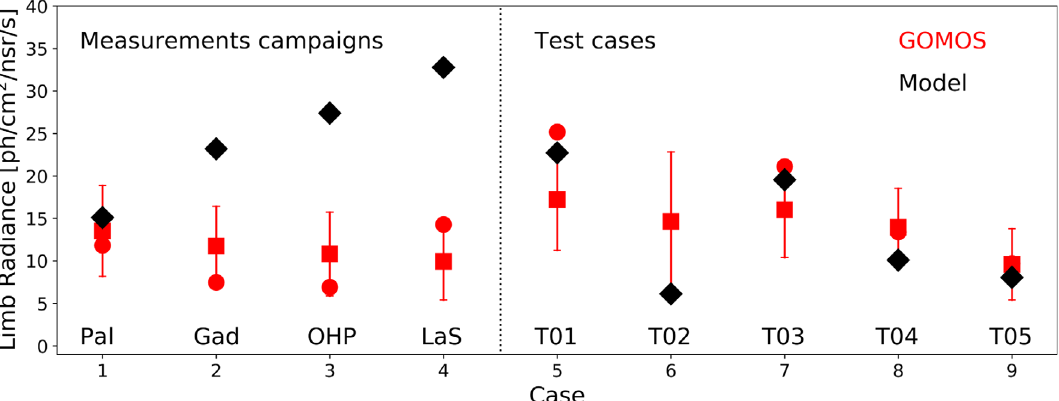
Fig. 6. In red squares are represented OH(8 – 4) integrated limb radiances from GOMOS between 925 nm and 955 nm averaged within a month and ±15 (cid:3) latitude for several cases. Corresponding simulations are associated with the black diamonds and the closest observations are in red